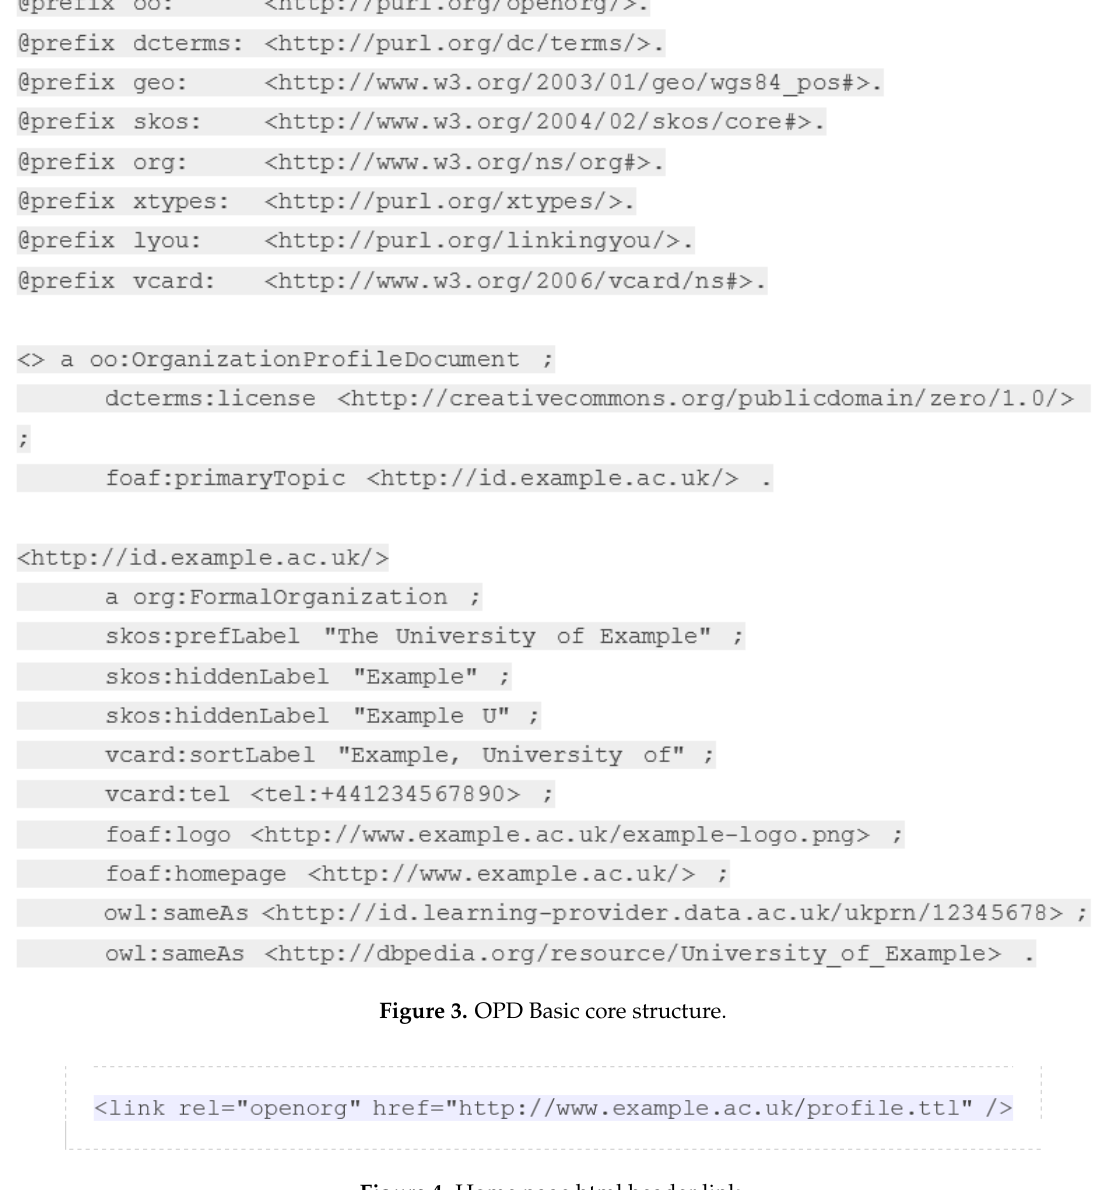
Figure 4. Home page html header link.